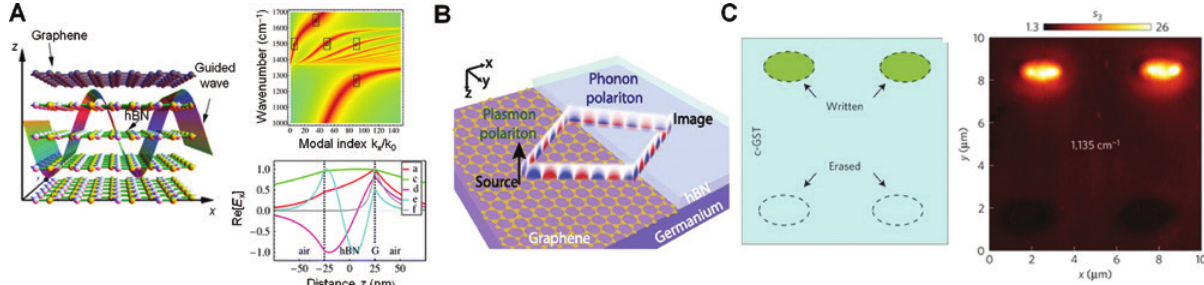
Figure 27: Examples of hybrid platforms with PhPs. (A) Dispersion of hybrid modes emanating from strong coupling between the type II hyperbolic GPhPs in hBN and the SPPs in graphene (top right panel) in a graphene-hBN heterostructure (left panel). The x -component of the electric field, E across the heterostructure for the modes designated in the top panel. [Reprinted (adapted) with permission from [109]. Copyright 2015 American Chemical Society.] (B) Negative refraction at the interface of a graphene-hBN lateral heterostructure: An SPP wave supported on graphene refracts negatively to a GPhPs supported on hBN in the spectral regime where it has a type I hyperbolic dispersion. (Reprinted with permission from [312]). (C) Re-writable patterns on GST by changing its phase. The GST rests on a quartz substrate operating within its reststrahlen band thus supporting SPhPs. The different GST phases provide a different dielectric environments for the SPhPs; this causes SPhP scattering at the boundaries of the elliptical amorphous GST areas thereby giving rise to the localized modes visualized with s-SNOM (right panel). (Reprinted by permission from Springer Nature Customer Service Centre GmbH: Springer Nature-Nature Materials [313]. Copyright